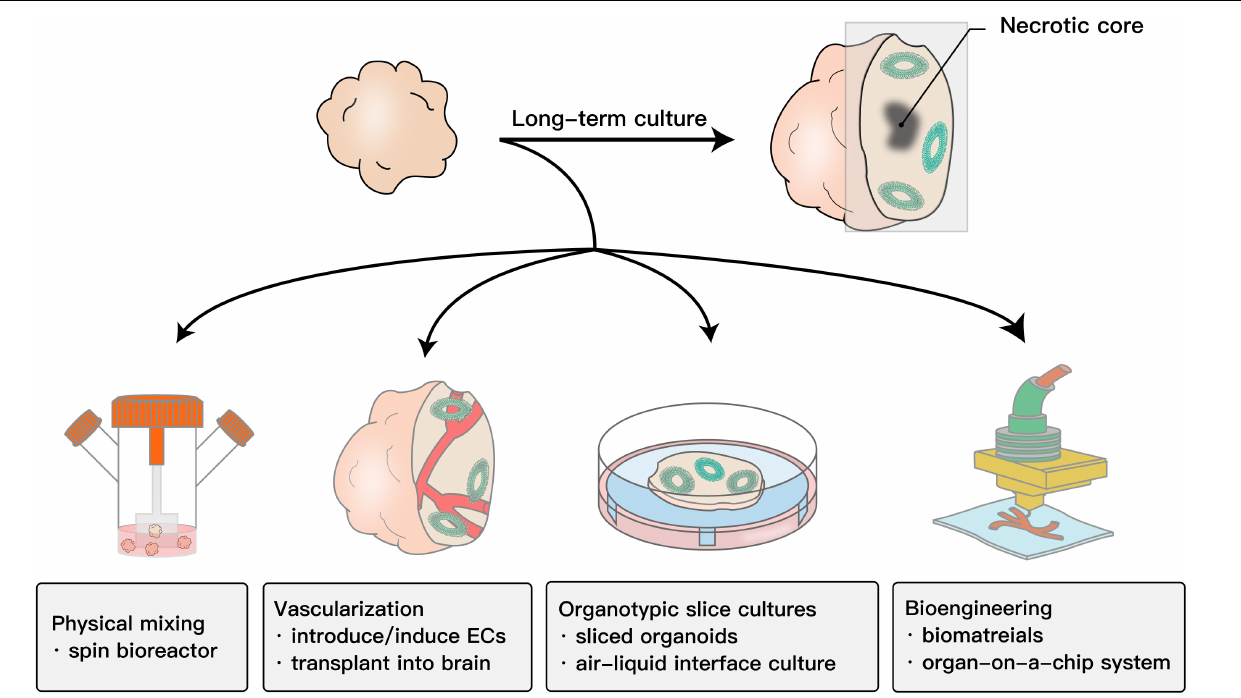
FIGURE 1 | Schematic showing the methods to improve the survival and maturation of brain organoids. Due to the lack of in vivo circulatory system, the progenitor proliferation is reduced over long-term culture. The insufficiency of nutrients and oxygen in the inner part of brain organoids impedes the maturation and differentiation of neurons and glial cells. To promote nutrient and oxygen diffusion, physical mixing is the most common method. Adapting bioengineering methods, including vasculature or scaffolds created by 3D printing and organ-on-a-chip systems such as microfluidics, to brain organoid systems also works. In addition, adapting the organotypic cultures into a brain organoid culture system by slicing organoids to reduce the thickness or further culturing them on an air-liquid interface system could also promote the absorption of oxygen and nutrients. The most essential cause of this problem is that brain organoids lack a functional vascular system. Building functional blood vessels could solve this problem to a large extent. Such strategies include introducing/inducting ECs or implanting them into the mouse brain.